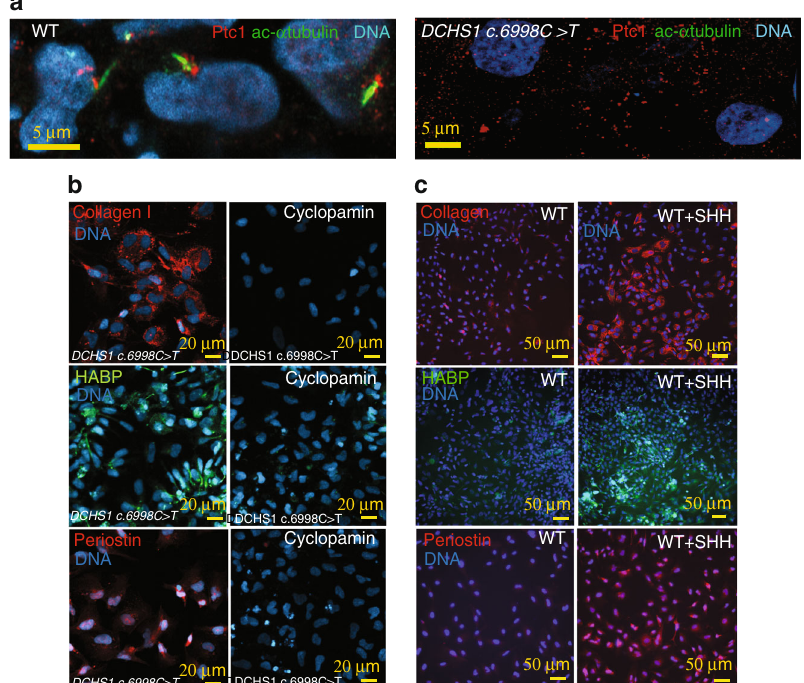
Fig. 6 SHH over-activation in mutated ( DCHS1 c.6988 C>T ) cells. a SHH receptor patched I (Ptc1) and the cilia (anti-acetylated α − tubulin) were co-stained on both ciliated wild type (WT) or unciliated DCHS1 c.6988 C>T cells. The confocal images are representative of 3 separate experiments and 180 scored cells in each group. Hyaluronan, collagen I and periostin were visualized by anti-HABP antibody, anti-collagen I and anti-periostin antibodies, respectively in cultures of VIC derived from both mutated ( DCHS1 c.6988 C>T ) or wild-type (WT DCHS1 ) HPVCs treated with cyclopamine ( b ) or SHH ( c ), respectively. To quantify collagen I, hyaluronan and periostin, 3 fi elds in 5 separate experiments were scored using the image thresholding mode of Image